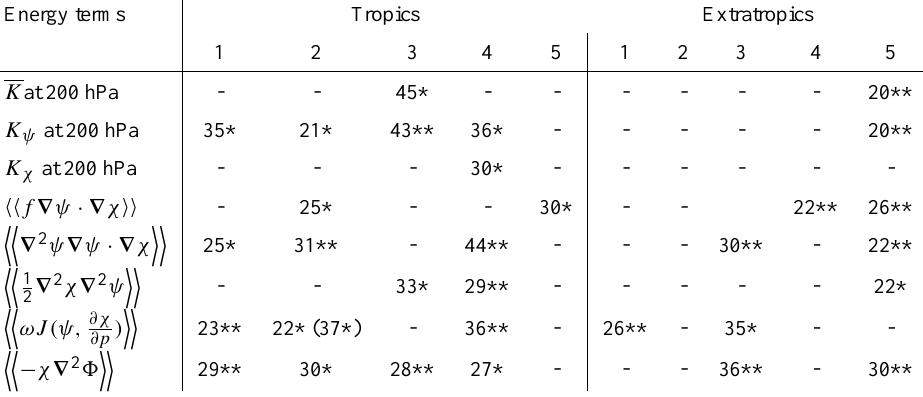
Table 3. Dominant periodicities in the energy parameters during five summers (NDJF 1985–1986, 1986–1987, 1987–1988, 1988–1989, 1989–1990) over tropical and extratropical South America. Values are expressed in days Energy terms